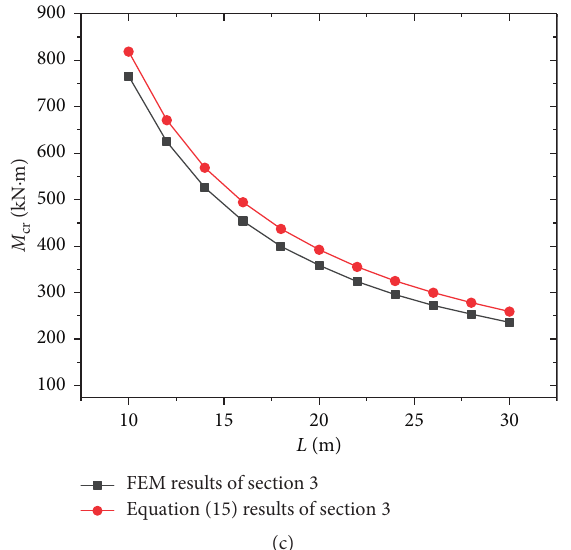
Figure 13: Relationship between critical moments and span (section 3). (a) 􏽥 R � 0, (b) 􏽥 R � ( 1/2 ) 􏽥 R